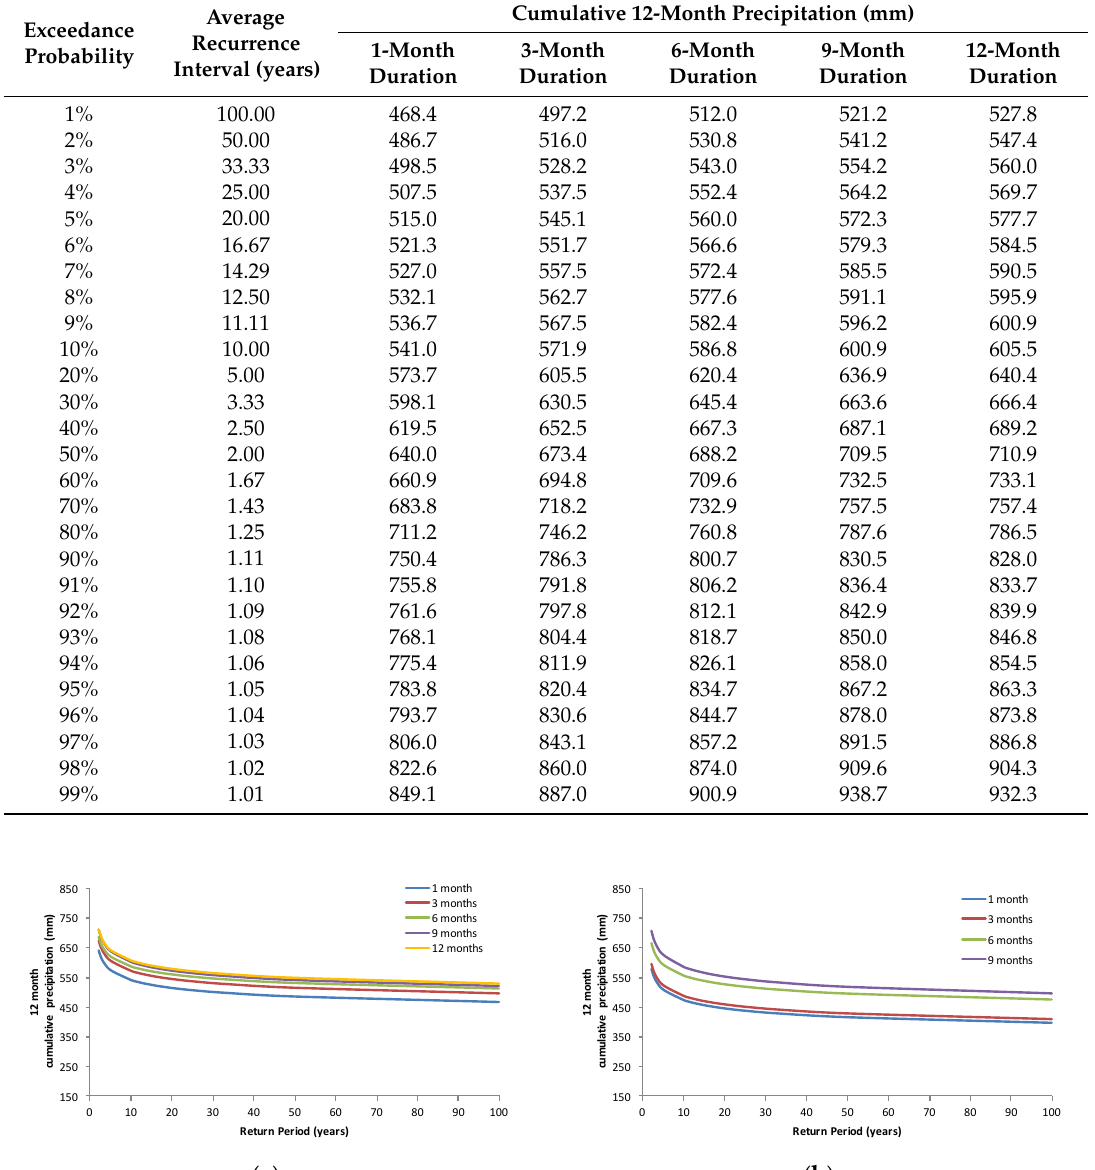
Table 4. Fitted gamma distribution for São Francisco